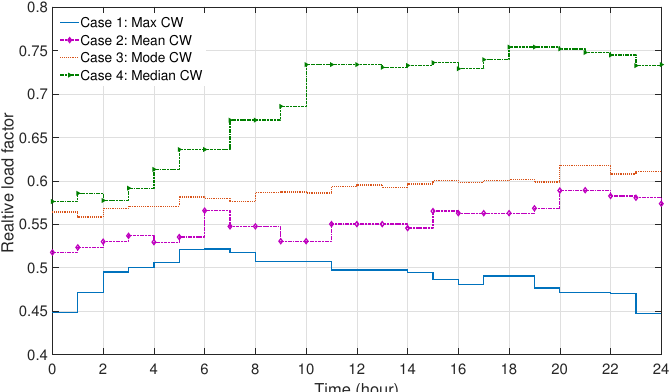
Figure 6. Relative load factor of gas consumption in power segment.